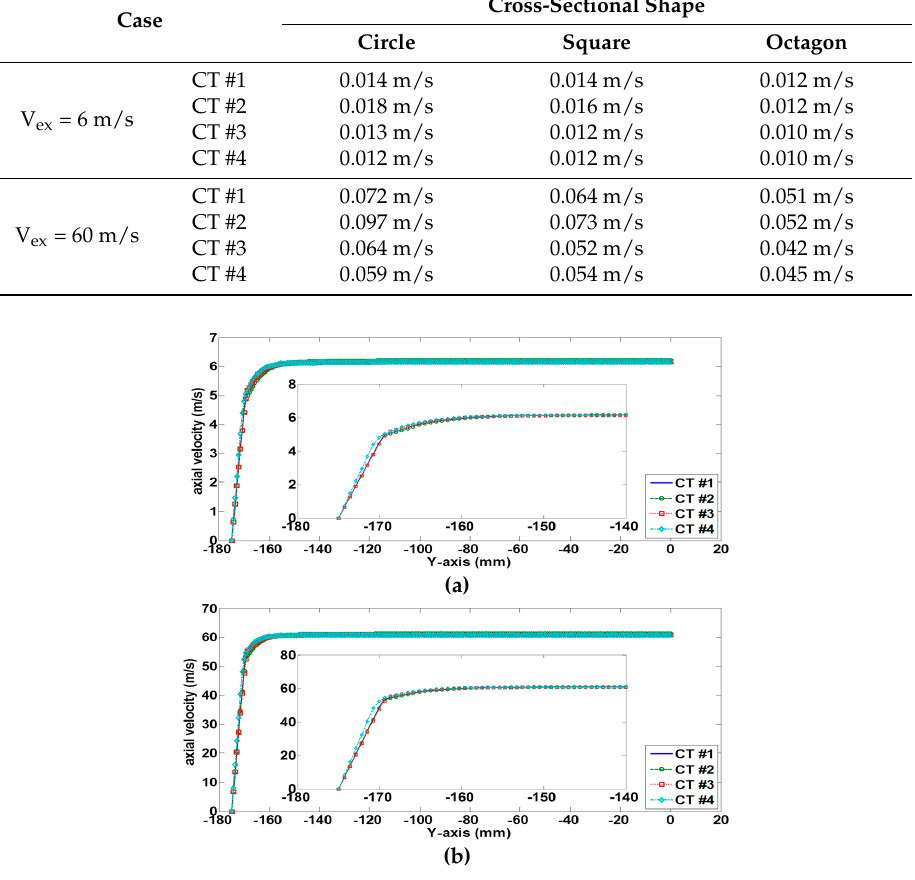
Figure 6. Axial velocity profiles at the circular cross-sectional contraction exits, ( a ) V ex = 6 m/s; ( b ) V ex = 60 m/s.